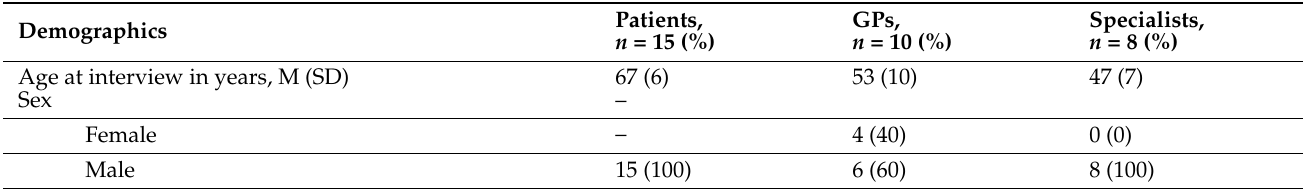
Table 3. Characteristics of interview